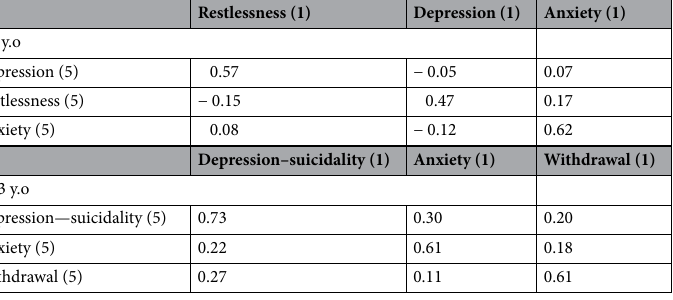
Table 3. Fact or correlation between 1st and 5th wave. In bold: correlation with p < 0.05. (1) first wave; (5) fifth